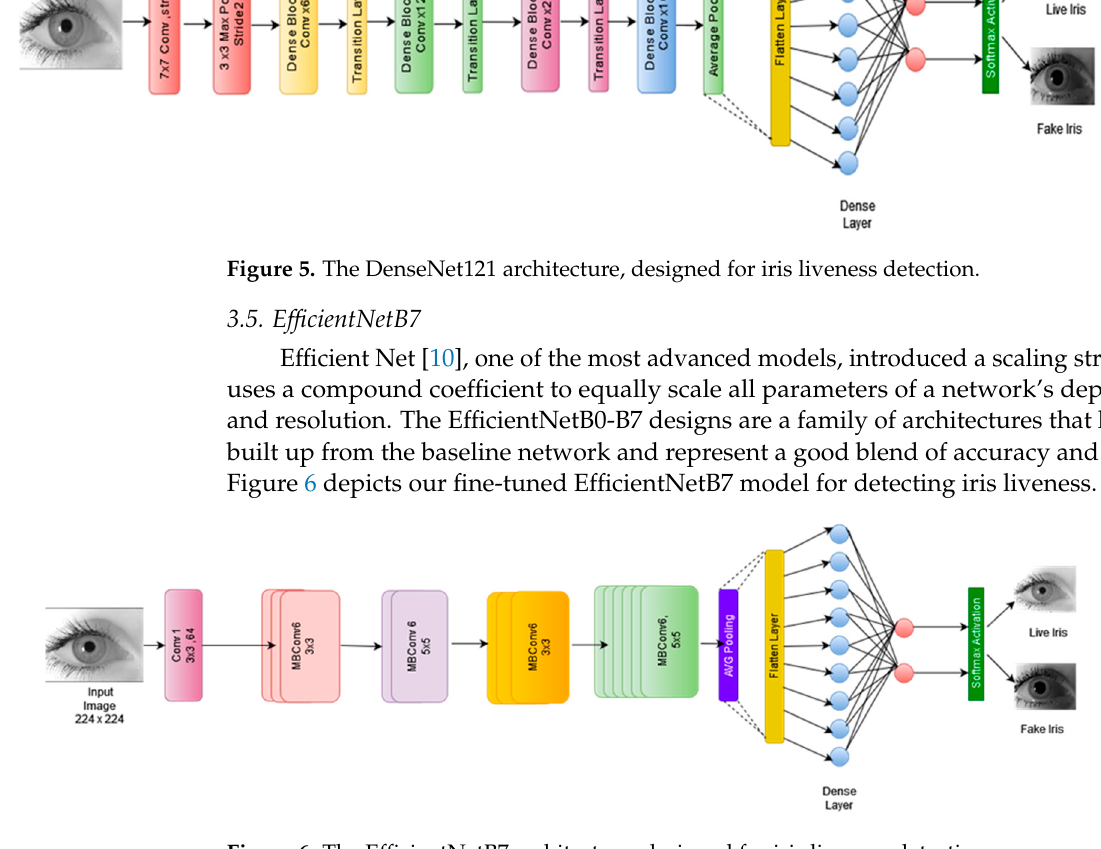
Table 1. The Clarkson dataset description.